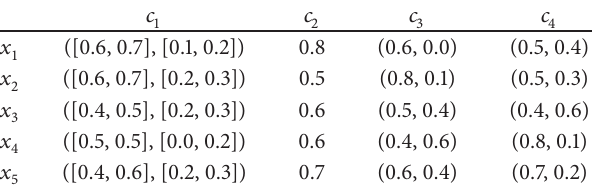
Table 4: Evaluation information at 𝑡 4 time episode.